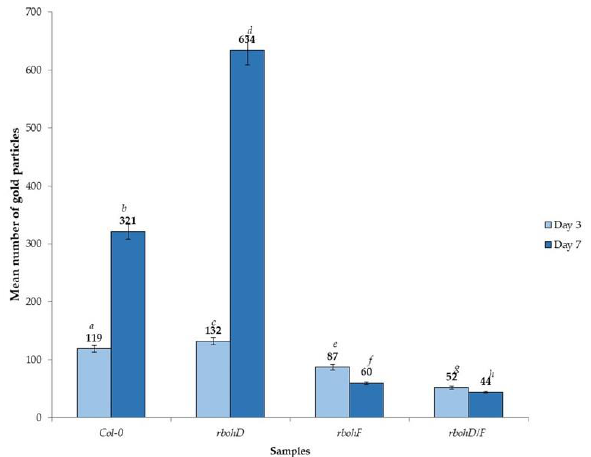
Figure 7. TuMV detection in rbohF and rbohD/F leaf tissues 3 ( A , C ) and 7 days ( B , D ) after virus inoculation examined by immunogold electron microscopy. ( A ) TuMV epitope localization (*) around multivesicular structures (MVB) in rbohF phloem cells. Phenolic-like compounds (#) near MVB. CW—cell wall; v—vacuole. ( B ) TuMV epitope presence (*) along virus particles (VPs; arrowheads) in vacuole (v) and around single membrane with tubule structures (SMTs) in rbohF . Phenolic-like compounds (#). m—mitochondrion. ( C ) TuMV epitope (*) in vacuole (V) and around changed (black arrows) cell wall (CW) with paramular bodies (PMBs; diamond head arrow) in rbohD/F phloem parenchyma cell. ( D ) TuMV epitope (*) in vacuole (v) rbohD/F xylem parenchyma cells (XP). Phenolic-like compounds (#) inside xylem tracheary elements (X).